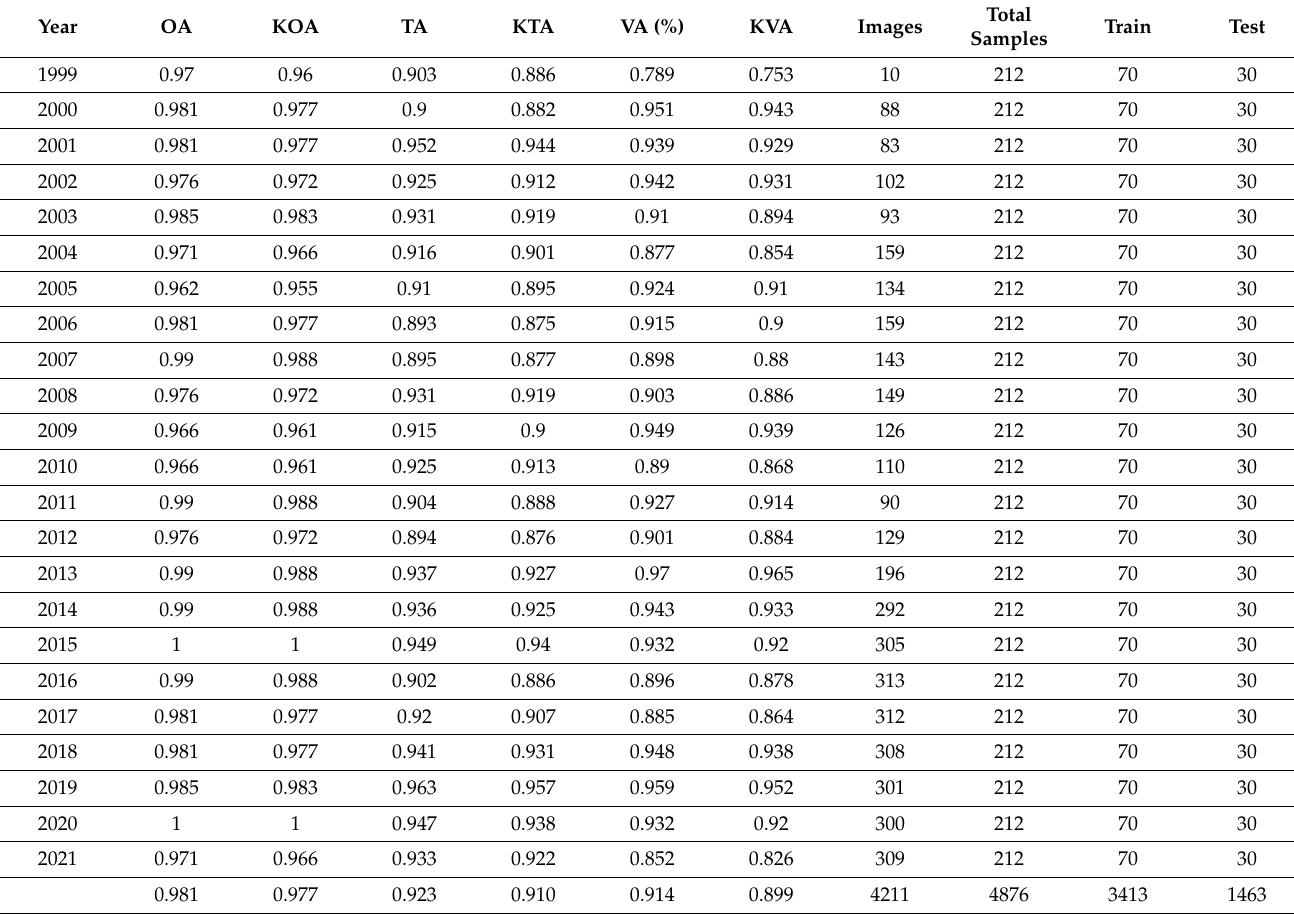
Table 3. Random forest classification accuracy over Lake Chad watershed. Where OA is overall accuracy, KOA is the kappa overall accuracy, TA is the test sample accuracy, KTA is kappa test accuracy, VA is the validation sample accuracy, and KVA is kappa validation